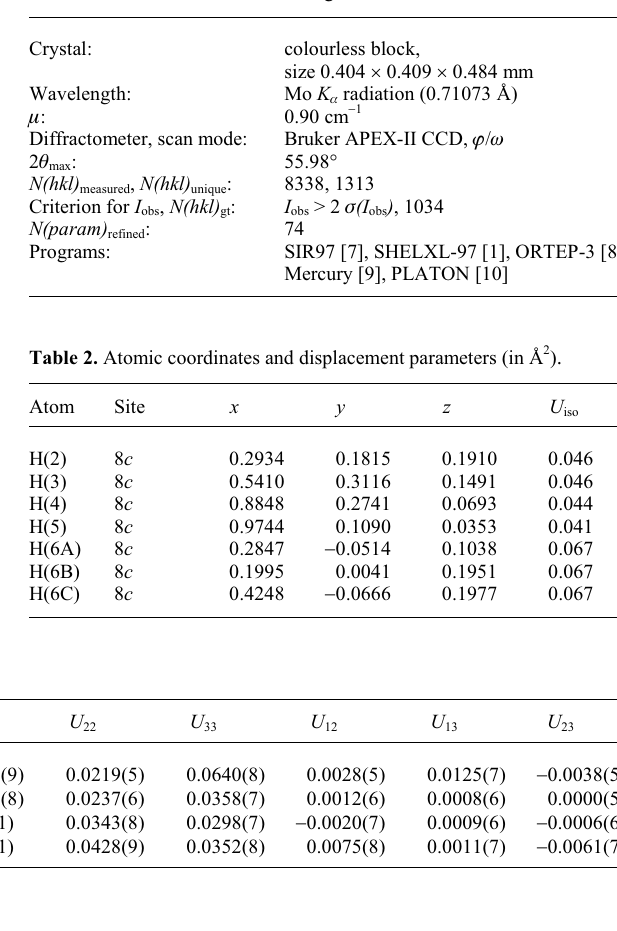
Table 1. Data collection and handling.